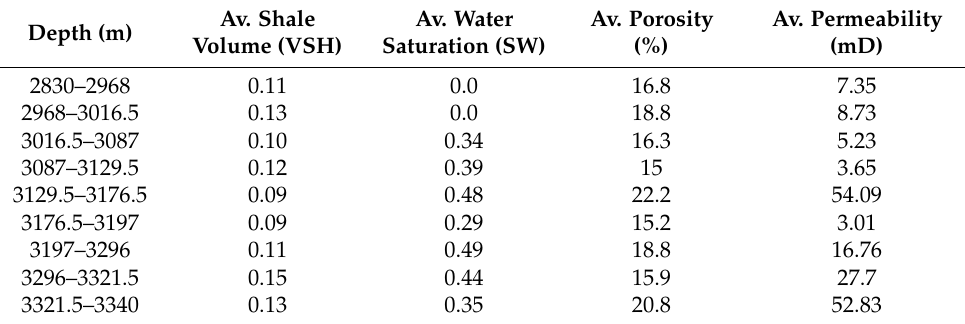
Table 3. Petrophysical properties using well log data from Srikail